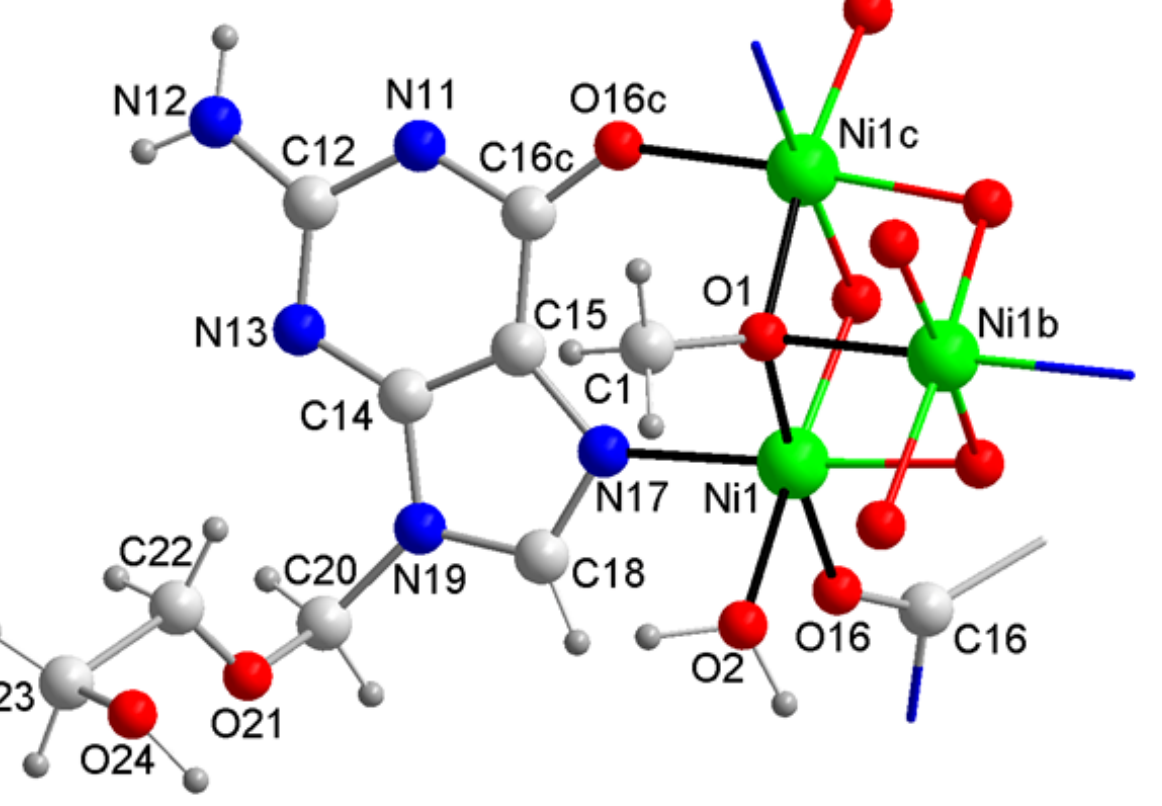
Figure 1. The asymmetric unit in the crystal of 1 , with the numbering scheme for non-hydrogen atoms. Symmetry codes: b = #2 = –x + 1/4,y,-z + 1/4, c = #3 = z,–y + 3/4,-x + 1/4. Table 2. Coordination bond lengths and other relevant inter-atomic distances (Å) and trans-coordi- nation angles (°) in the crystal of compound 1 , [Ni(acv-H)(MeO)] 4 ·8H 2 O. See also Figures 1 and 2 for the numbering of non-H atoms.